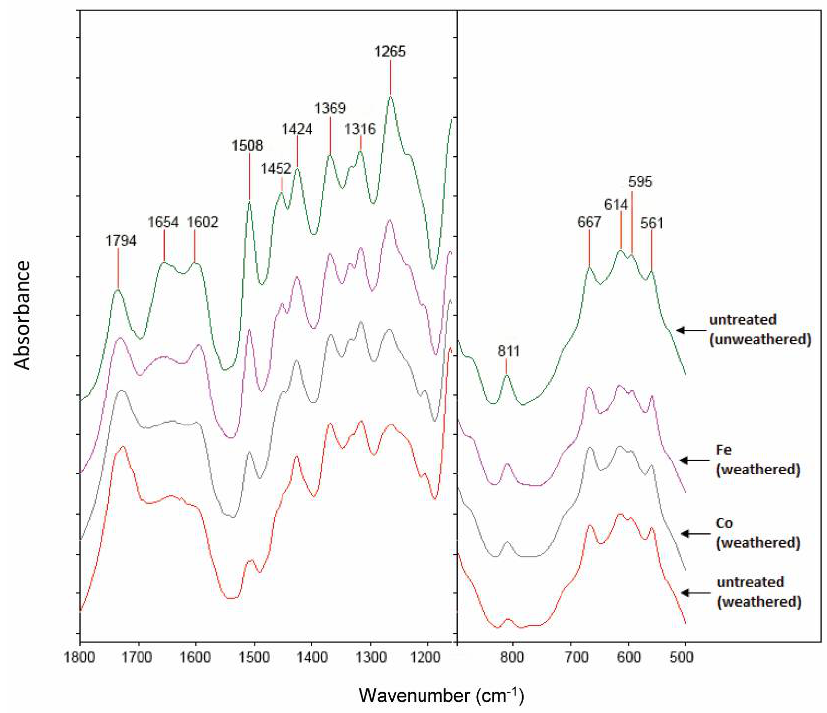
Figure 4. FTIR spectra of untreated and treated veneers exposed to natural weathering in Australia.